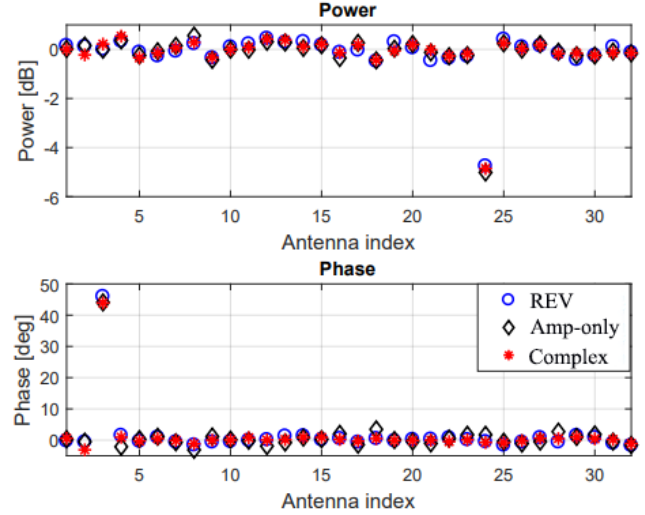
Figure 7. Array calibration results based on three methods with R = 5.85 m.